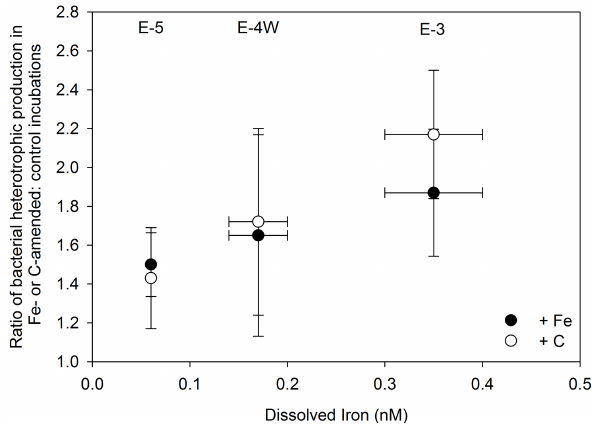
Figure 2. Extent of stimulation of bacterial heterotrophic produc- tion by Fe ( + Fe) or C ( + C) addition and in situ dissolved iron (DFe) concentrations. Ratios of bacterial production in the Fe- or C-amended treatments to the controls correspond to the time points when significant differences were detected for the first time in the cultures (see Fig. 1), and the error bars denote the cumulated error of the bacterial production measurements in the control and the Fe- or C-amended treatments, respectively. For DFe, mean values ± SD of the surface mixed layer are given (see Table